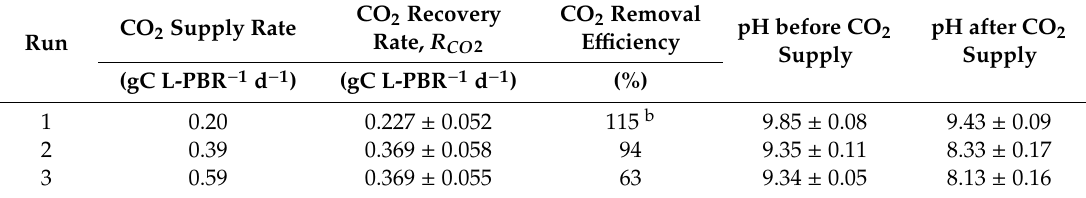
Table 2. Average CO 2 fixing rate and pH before and after CO 2 supply in absorption columns a